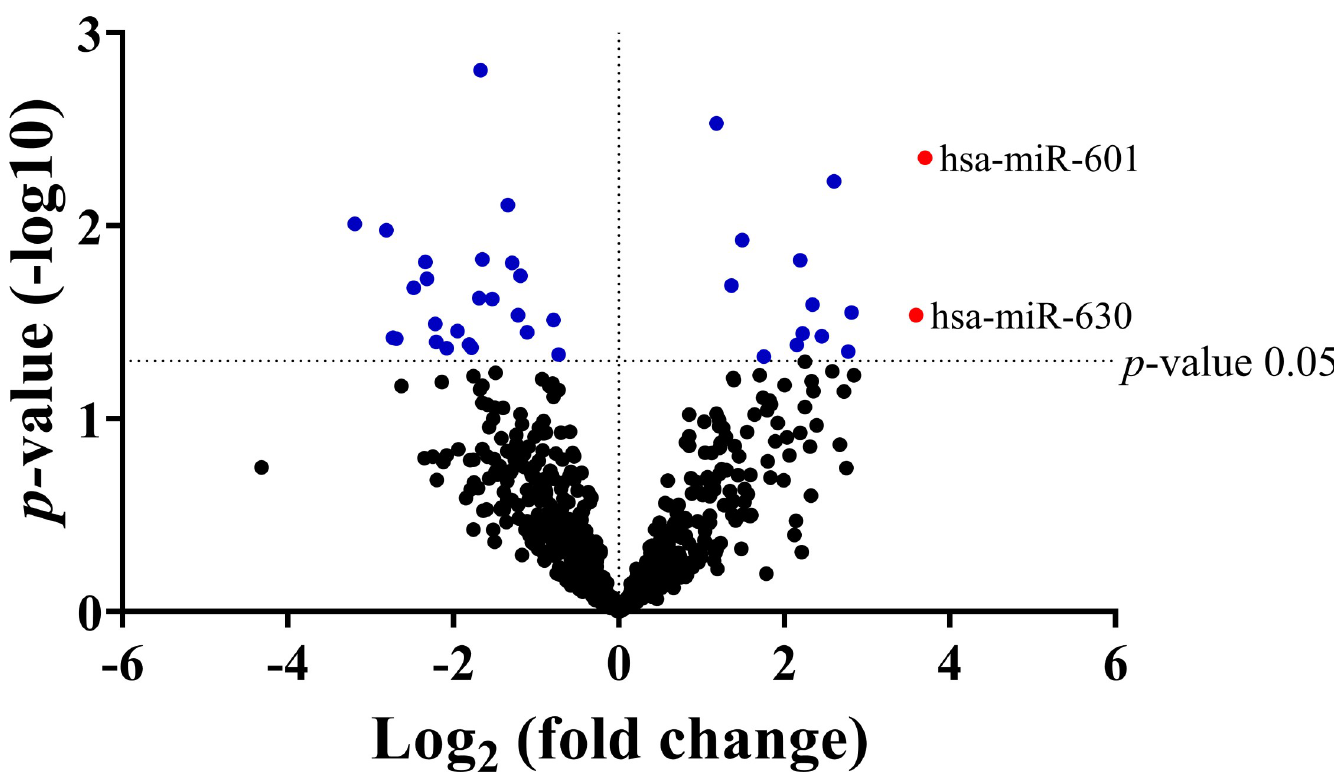
Fig 1. Volcano plot of miRNAs expression profiling. The blue dots represent miRNAs that demonstrate a significant change in expression (left side; downregulated miRNAs, right side; upregulated miRNAs). The red dots showed the two candidate miR-601 and miR-630. The significance value was indicated with a p -value < 0.05.